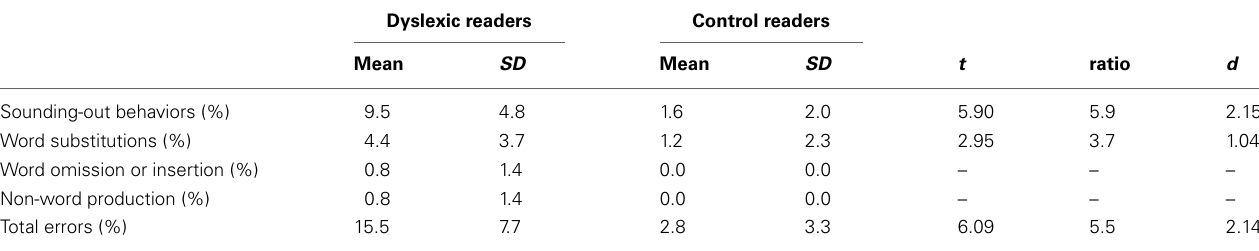
Table 3 | Group results for